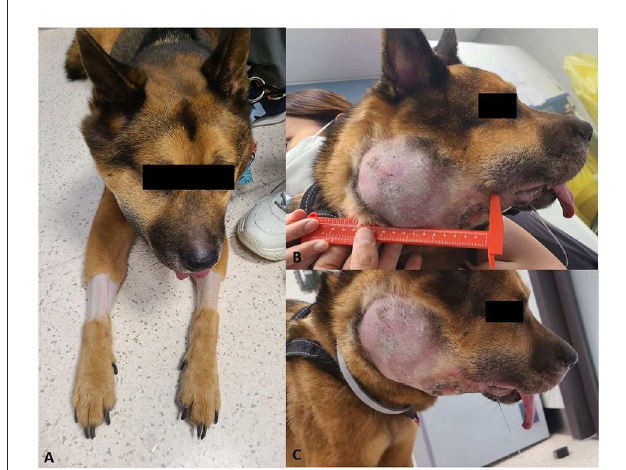
FIGURE1 Clinical presentation of the dog with suspected PBL. (A) Cervical mass on the right side. (B, C) Right oral/neck mass was very large (approximately 15 ×